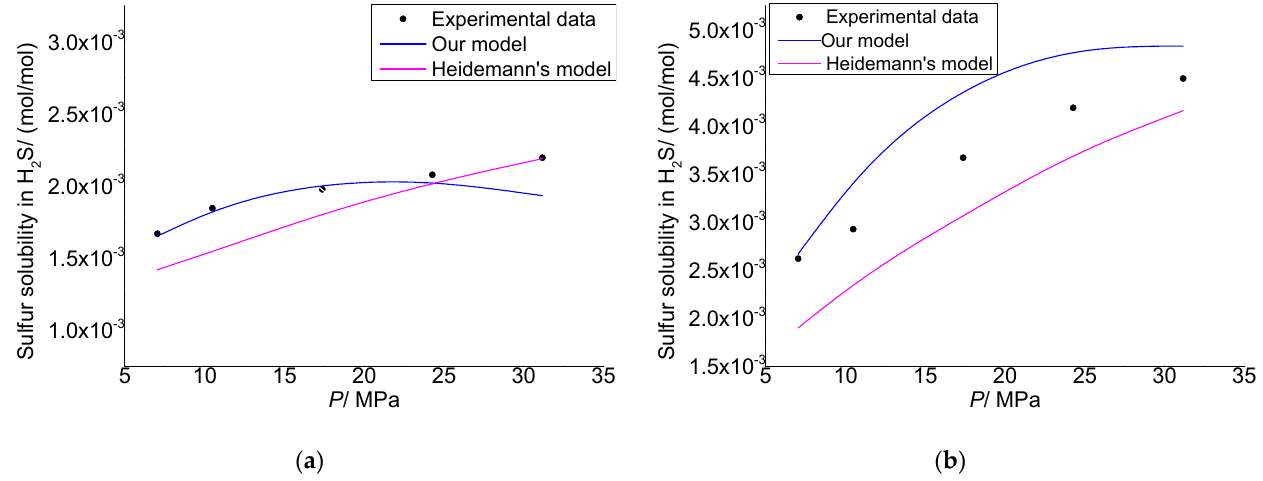
Figure 1. Comparison of sulfur’s solubility in H 2 S. ( a ) 316.26 K; ( b ) 338.71 K.